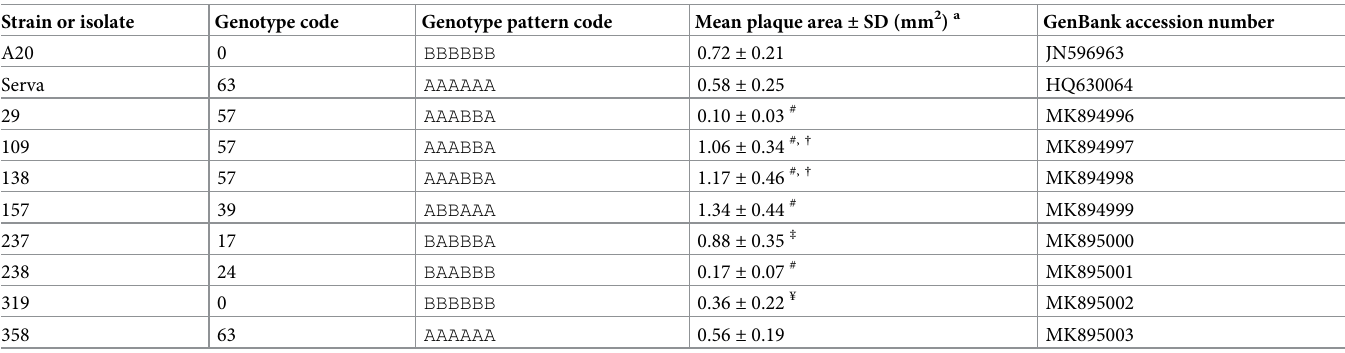
Table 3. Comparison of plaque areas in CEK cells of 8 recombinant viruses at 48 hpi with those of Serva and A20 parental strains. Strain or